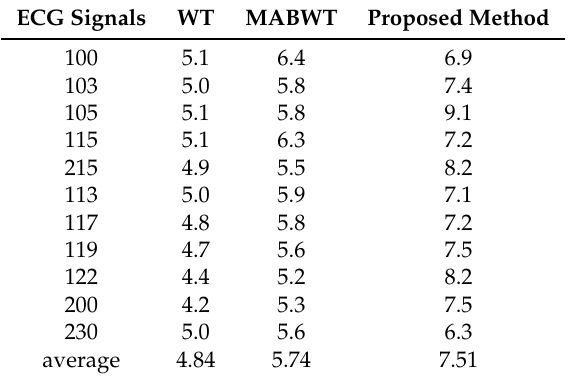
Table 3. SNR imp comparison of de-noising results using hard threshold for ECG signals with WGN (5 dB).